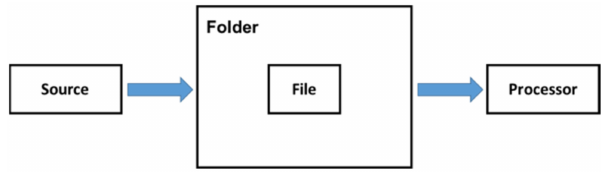
Figure 8. The file transfer integration